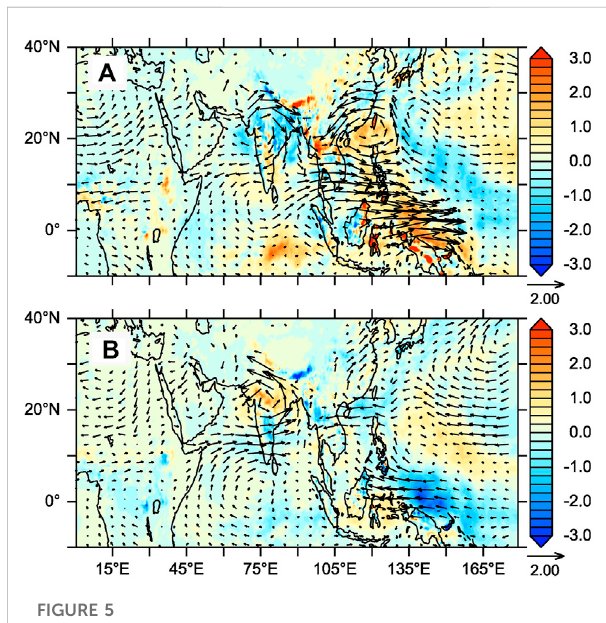
FIGURE 5 Spatial map of difference in the JJAS time-mean (1951 – 2005) precipitation (mm day -1 , shaded) and 850 hPa winds (ms -1 , vectors) (A) (HIST Aero - HISTNAT) (B) (HIST GHG –